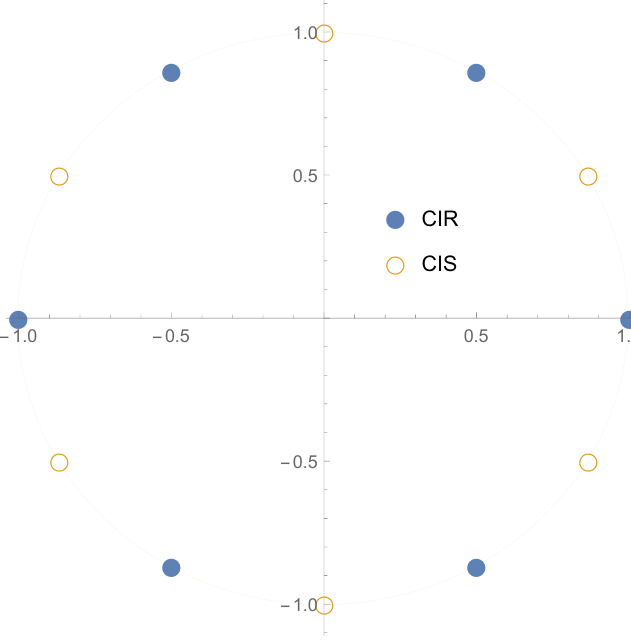
Figure 2. Nodes of the CIR and CIS NIZT methods for N = 6 in the complex plane.